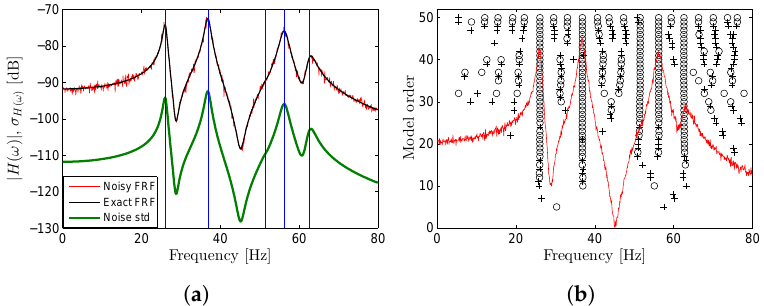
Figure 3. Element(1,1) of the FRF matrix contaminated with 10% noise: exact (black line) and noisy (red line) FRF, noise standard deviation (green line) and exact natural frequencies (vertical lines) ( a ); and stabilization diagram (with ‘ ◦ ’ denoting a pole with stable frequency and damping and ‘ + ’ a pole with stable frequency only) constructed with the LSCF estimator by identifying common denominator polynomial models with order ranging from 1 to 50 ( b ).